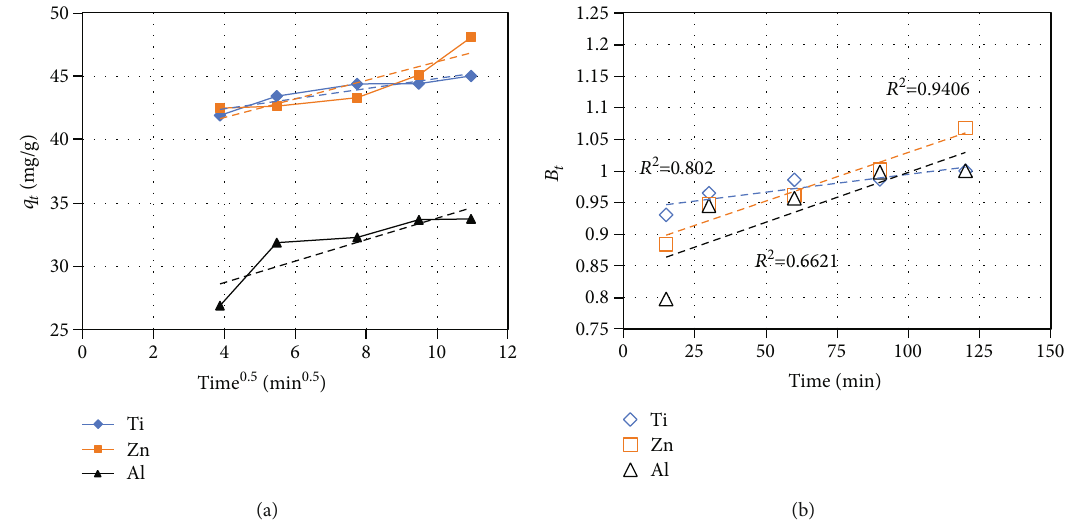
Figure 5: Adsorption mechanisms of Pb(II) onto all adsorbents: (a) intraparticle di ff usion model and (b) Boyd kinetic model.